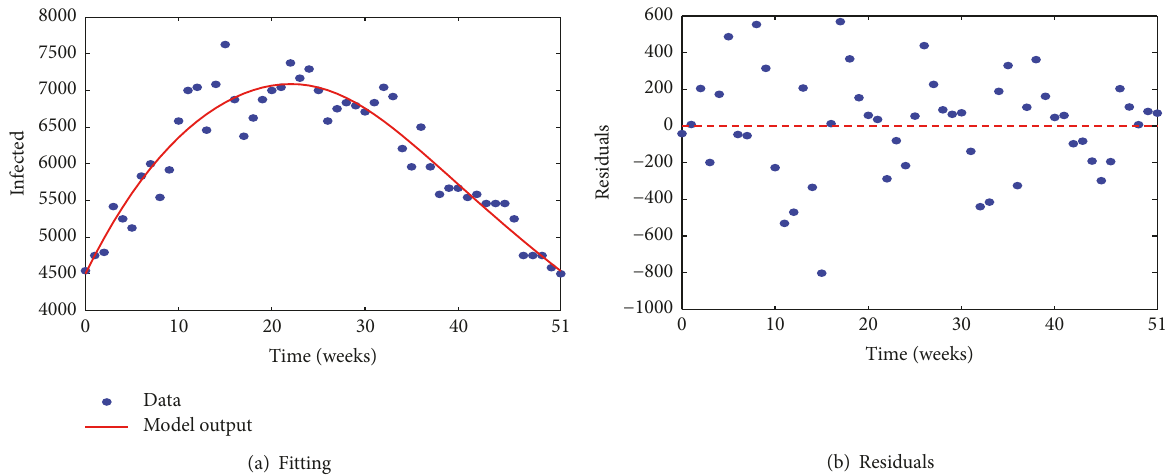
Figure 4: Fitting of the model equation (1) to the reported data in Table 2 and residual analysis using the estimated parameters.